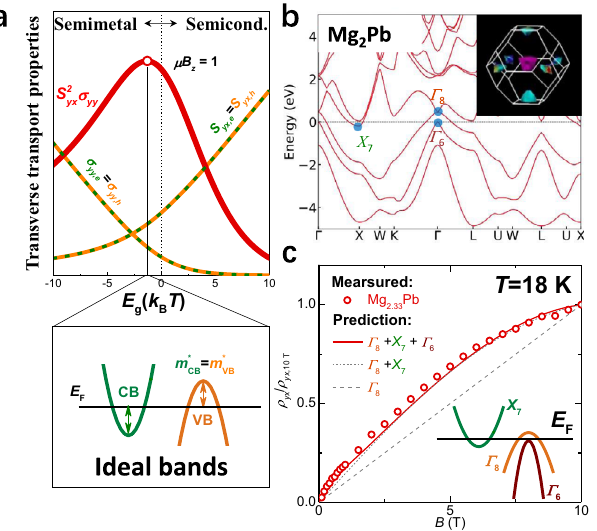
Fig. 4 Band structures for the idea case and for Mg 2 Pb. a Schematic of ideal band structure for bipolar enhanced transverse thermoelectric properties as a function of band gap ( Eg ). b Calculated band structure and the corresponding Fermi surface for Mg 2 Pb. c Normalized Hall resistivity ( ρ yx / ρ yx ,10 T ) with a three-band model prediction by the least-square fi tting. The decrease in slope of ρ yx vs. B at high fi elds indicates one valence band and one conduction band with comparable carrier mobilities and concentrations, and the increase of the slope at low fi elds indicates the involvement of an additional valence band having a higher carrer mobility and lower